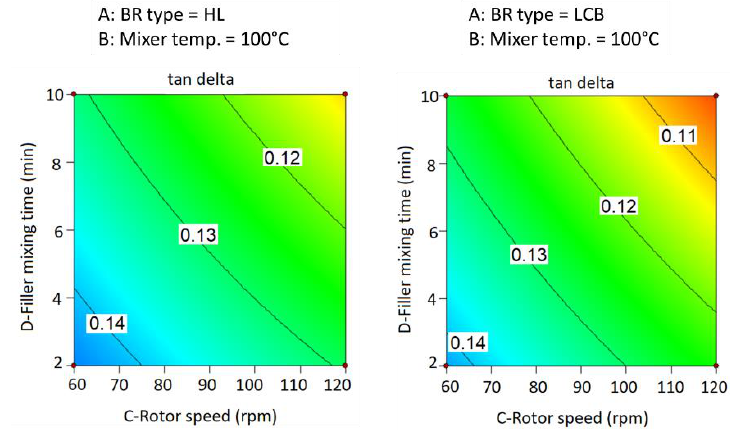
Figure 7. The effect of rotor speed and filler mixing time on tan delta in rubber compounds containing HL-BR and LCB-BR.